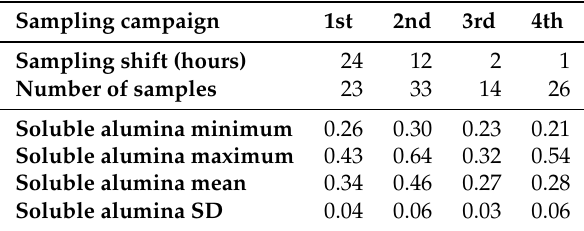
Table 1. Sampling collection parameters for the four sampling campaigns and descriptive statistics of their corresponding soluble alumina content